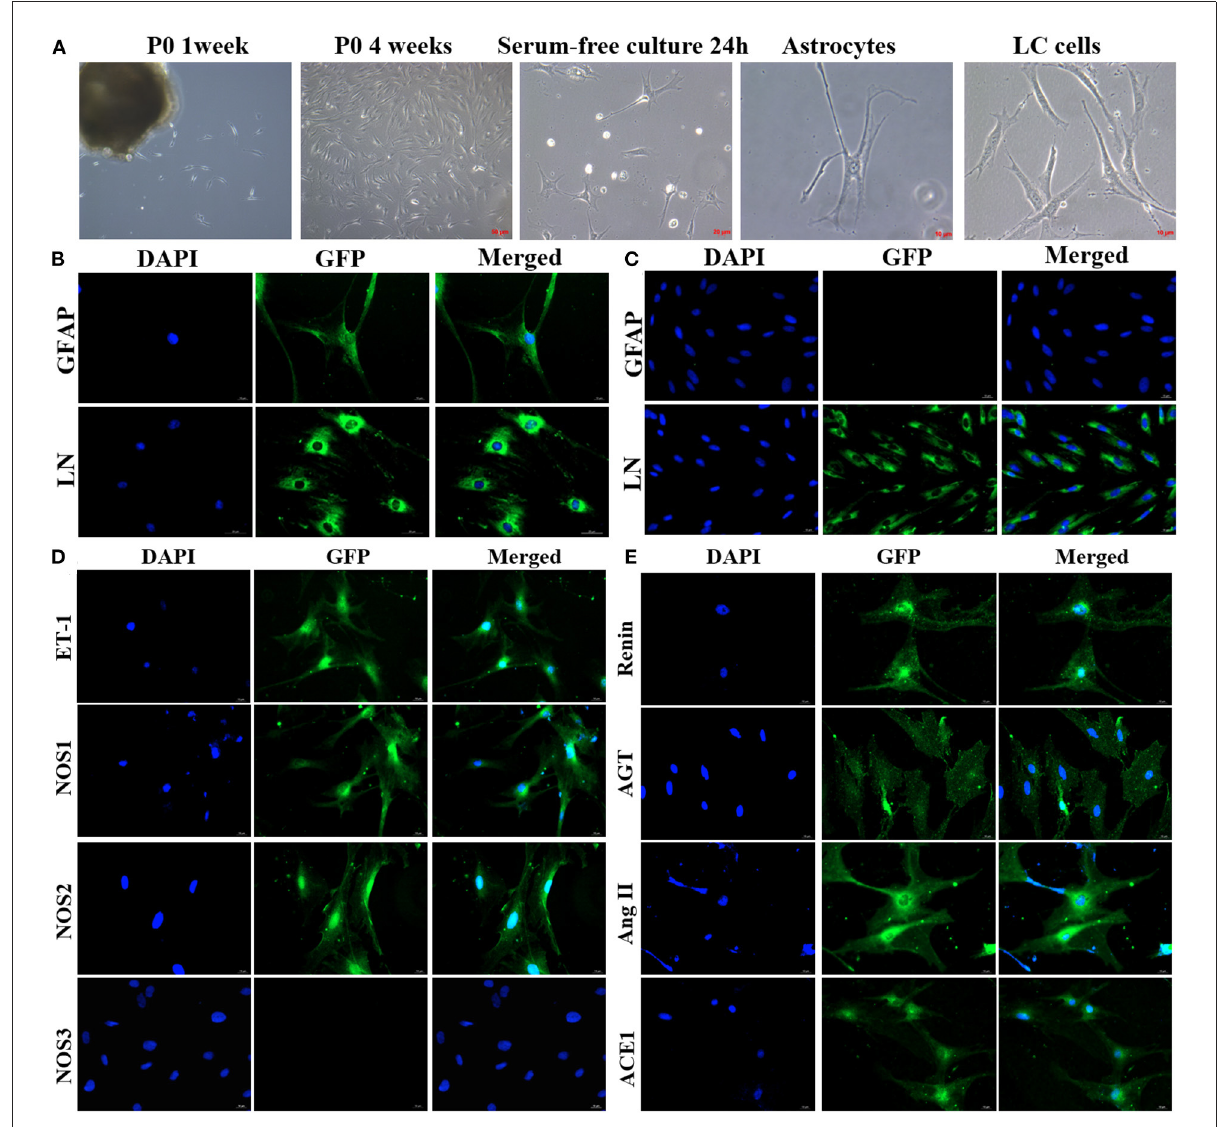
FIGURE7 Characterization of ONH astrocytes from explants of the rat LC plants. (A) Cells grew out of the explants of the LC within 1 week and reached confluence at about 4 weeks. ONH astrocytes had several processes with star shape morphology. LC cells appeared as flat, broad shaped cells. (B) ONH astrocytes showed positive staining for GFAP and LN. (C) LC cells showed negative staining for GFAP and positive staining for LN. (D,E) ONH astrocytes exhibited positive staining for ET-1, NOS1, NOS2, rennin, AGT, Ang, and ACE1, with negative staining for NOS3. ONH, Optic nerve head; LC, Lamina cribrosa; ET-1, Endothelin 1; GFAP, Glial fibrillar acid protein; LN, Laminin; ET-1, Endothelin 1; NOS, Nitric oxide synthase; AGT, Angiotensinogen; Ang, Angiotensin; ACE1, Angiotensin converting enzyme 1.